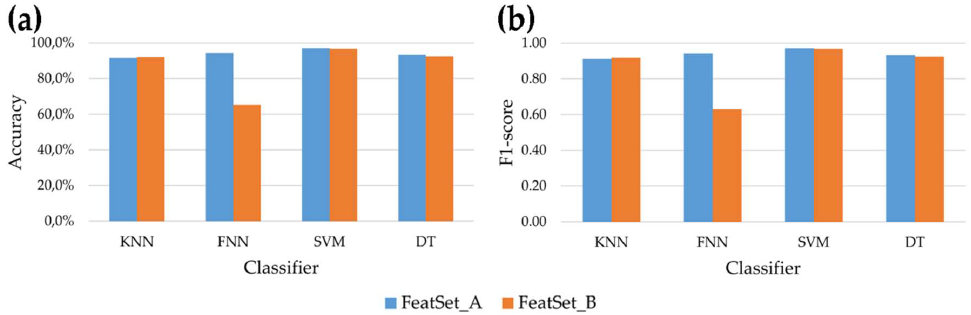
Figure 4. Mean accuracy ( panel a ) and F1-score ( panel b ) of the four classifiers across the seven activities (both static and dynamic activities), after post-processing, for the two sets of features.